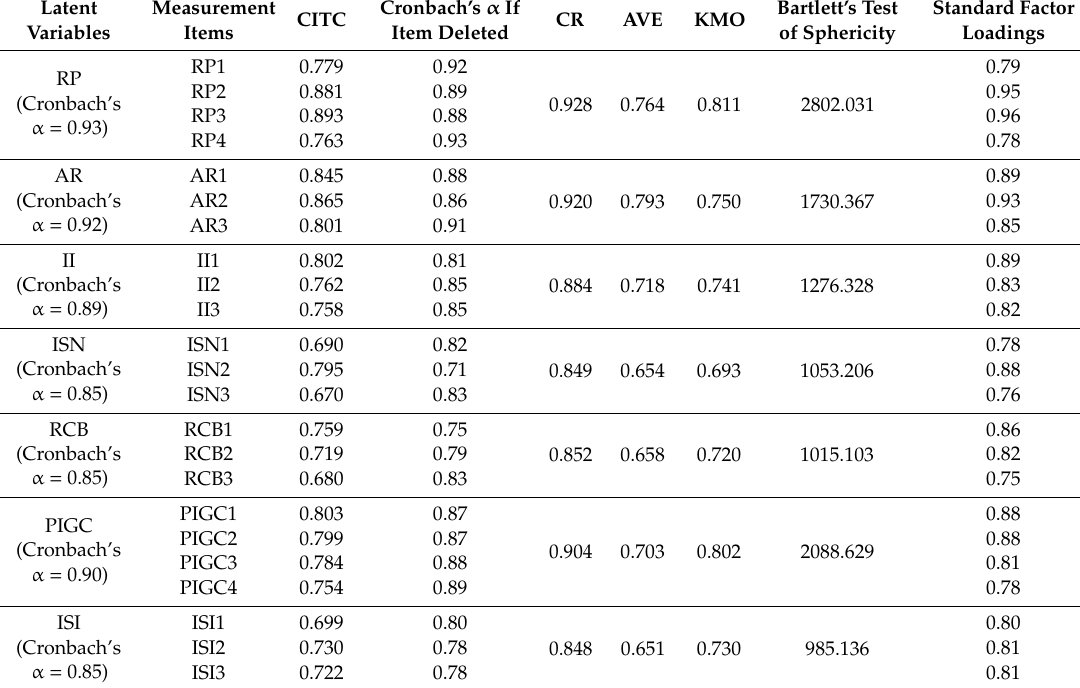
Table 3. Reliability, validity, and confirmatory factor analysis results.